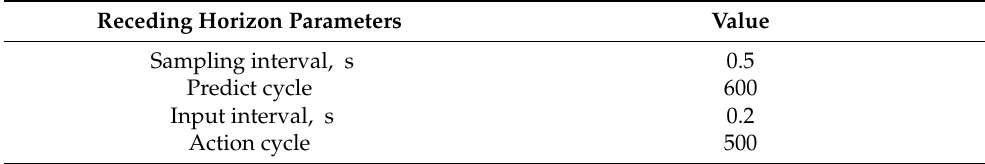
Table 2. Receding horizon